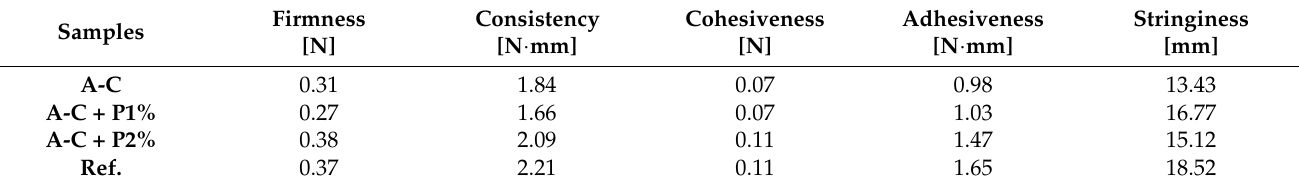
Table 1. Numerical values of the textural parameters measured by an immersion/de-immersion test for the samples pre- pared with ternary associations of A (1.25% w/w), C (1% w/w), and P (0%, 1%, and 2% w/w), and of the reference product (Ref.). Samples